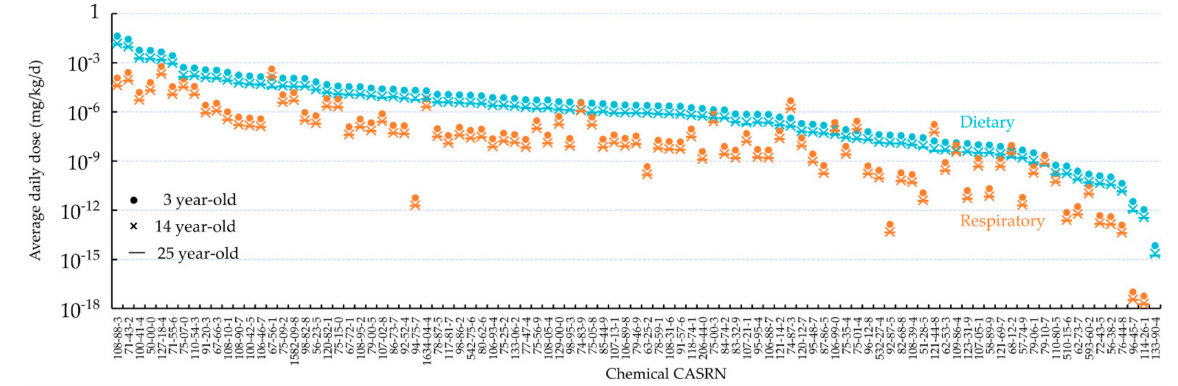
Figure 2. Average daily doses (ingestion in blue and inhalation in orange) of 95 organic chemicals for 3-, 14-, and 25-year-old individuals predicted in this study based on background emission rates from NEI, ranked by the average daily oral dose for age